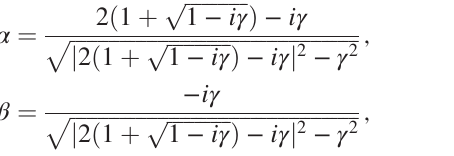
ffiffiffiffiffiffiffiffiffiffiffiffi p 1 − i γ